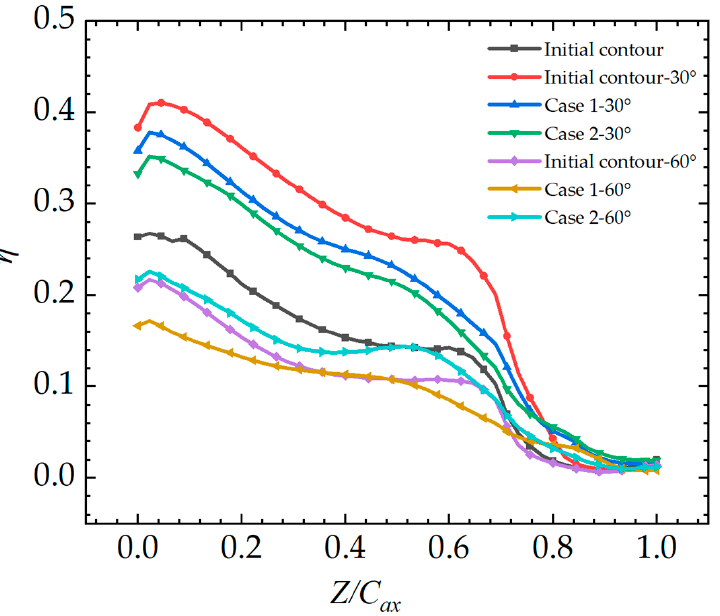
Figure 14. Axial distributions of laterally averaged film effectiveness on the endwall.